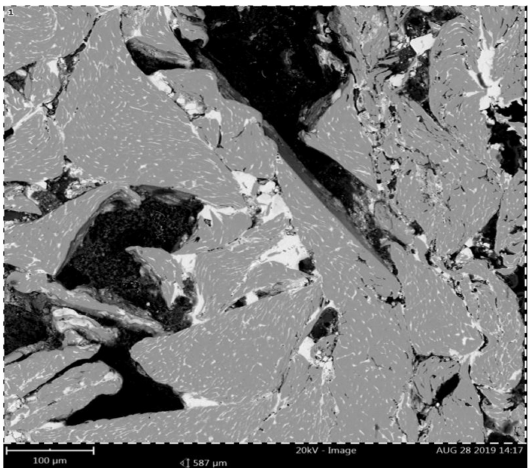
Figure 9. Representative microstructure area for EDS analysis.